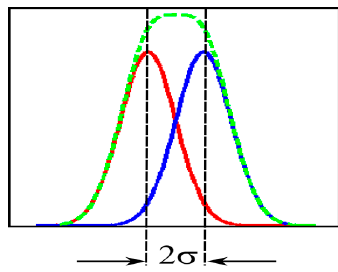
Figure 6. Separation limit (no-dip condition) for two superposed Gaussian distributions; σ : standard deviation.